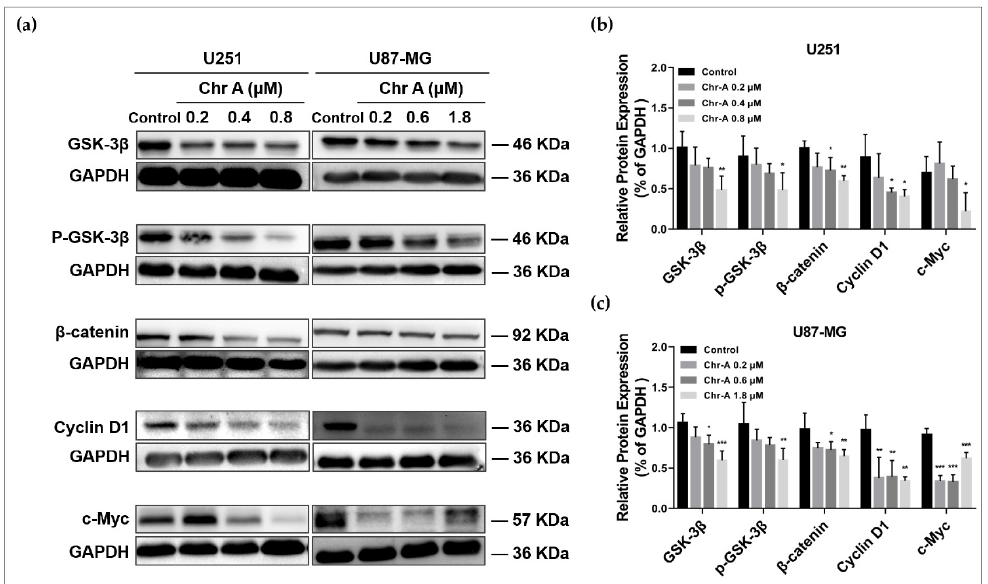
Figure 5. Chr-A mediates the Wnt/ β -catenin pathway in the U251 and U87-MG cells. ( a ) Western blot shows that Chr-A downregulates protein expression levels of GSK-3 β , p-GSK-3 β , β -catenin, c-Myc and cyclin D1 in the U251 and U87-MG cells. ( b ) Relative protein expression of GSK-3 β , p-GSK- 3 β , β -catenin, c-Myc and cyclin D1 in the U251 cells. ( c ) Relative protein expression of GSK-3 β , p-GSK-3 β , β -catenin, c-Myc and cyclin D1 in the U87-MG cells. Data are demonstrated as mean ± SD ( n = 4), * p < 0.05, ** p < 0.01 and *** p < 0.001 vs. the control group.